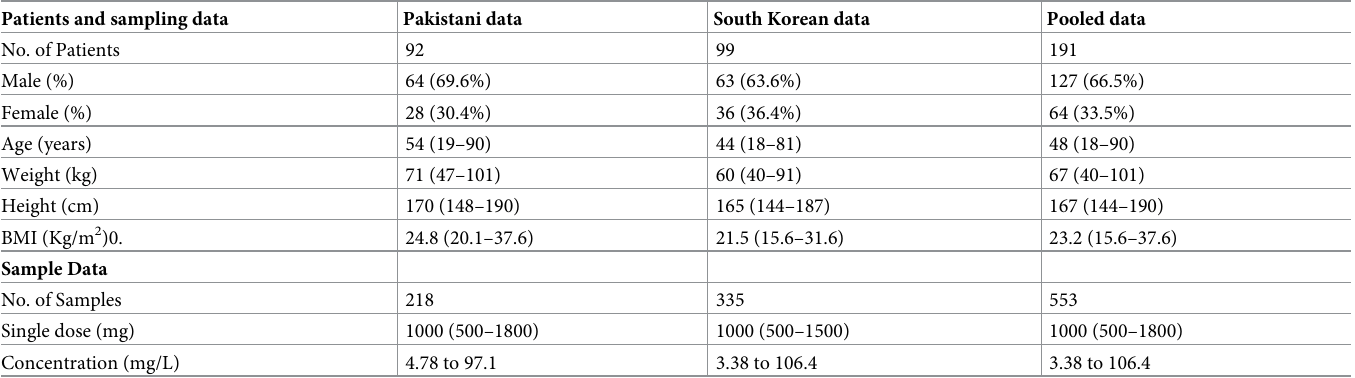
Table 1. Demographics and sampling data of patients. Patients and sampling